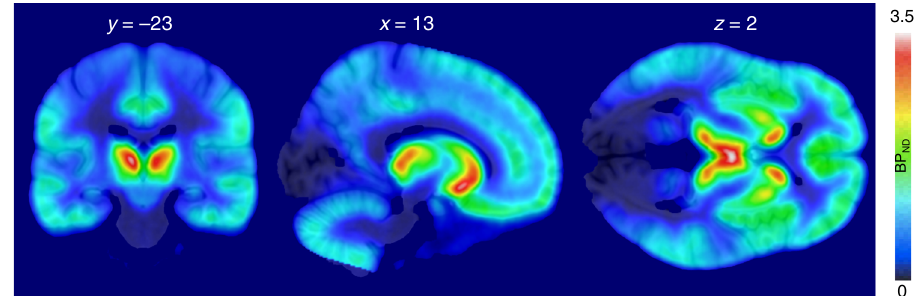
Fig. 2 Mean distribution of MOR in the brain as measured with [ 11 C]carfentanil ( n = 33) showing widespread MOR expression with highest densities in striatum, thalamus, and